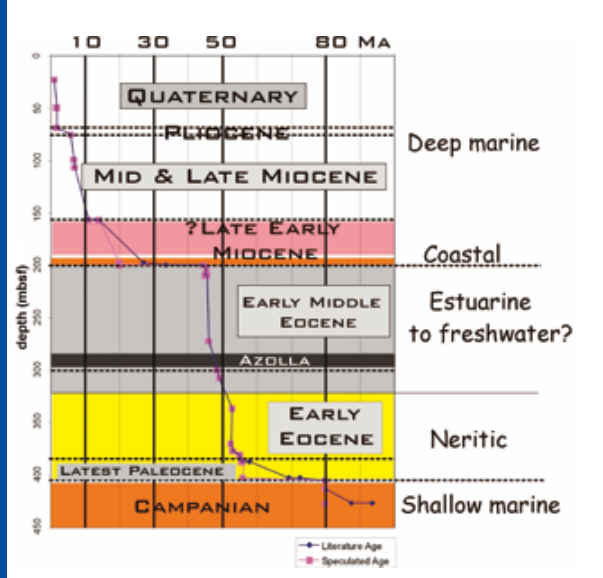
Figure 3. Biostratigraphy and age model (courtesy of Henk